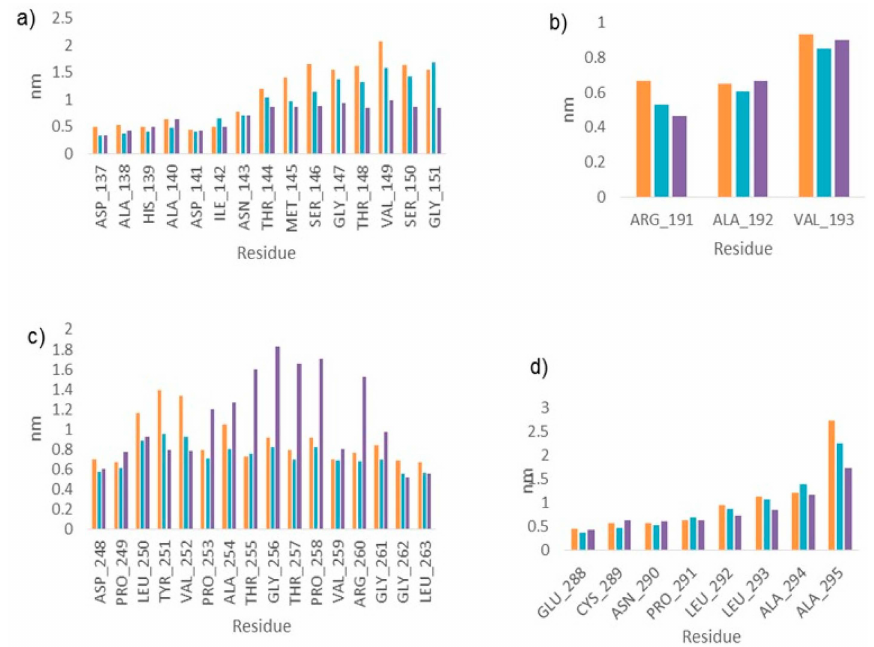
Figure 5. Root Mean Square Fluctuation analysis of C α in ( a ) loop 1, ( b ) loop 2, ( c ) loop 3, and ( d ) loop 4. Apo-LmARG (orange), LmARG-compound 1 (blue), LmARG-compound 2